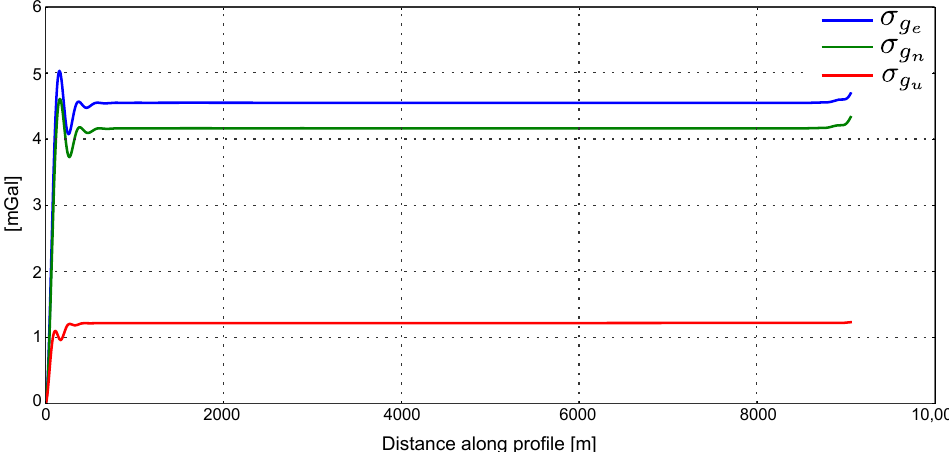
Figure 12. Variations of the formal errors on the east (blue solid curve), north (green solid curve) and vertical (red solid curve) gravity field components obtained from the covariance matrix given by the unscented Kalman filter. The three errors all stabilise after about 1000 time steps, which corresponds to a distance travelled on the profile of 750 m. Once stabilised, the value of σ g smaller than that of σ g and σ g e n